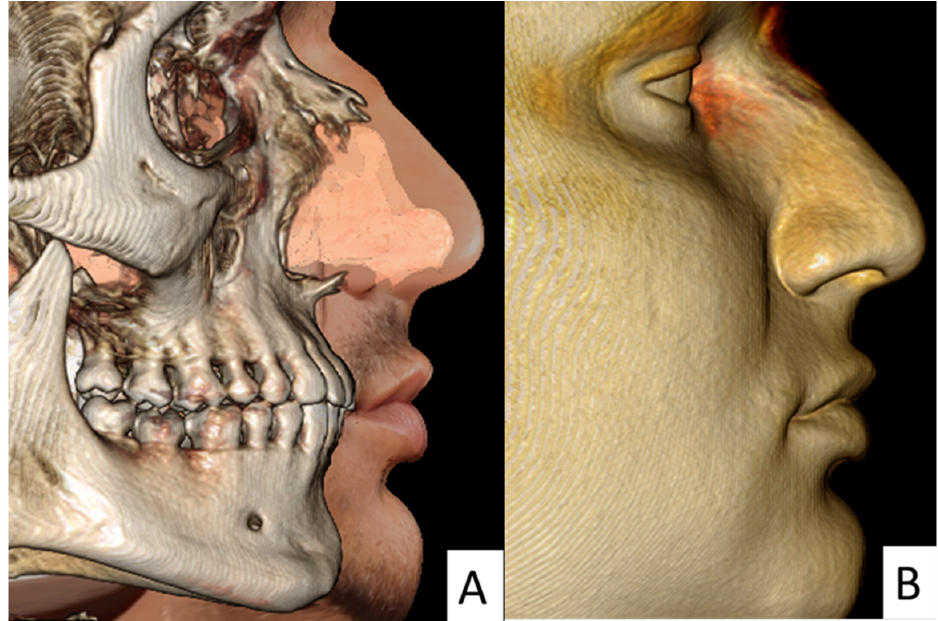
Figure 5. ( A ) Wrapped lateral profile view showed the profile view of the wrapped non-standardized photograph following the fixation of the selected soft tissue registration points. ( B ) Lateral direct CBCT soft tissue view. Table 1. Soft tissue measurements used in the study.